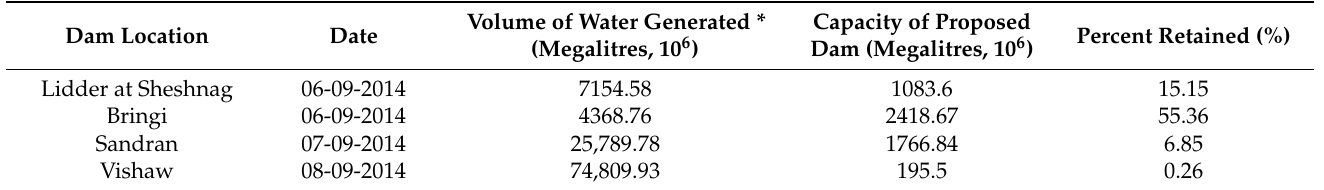
Table 6. The volume of water generated at different dates during the 2014-flood deluge of Kashmir valley and the volume of the proposed